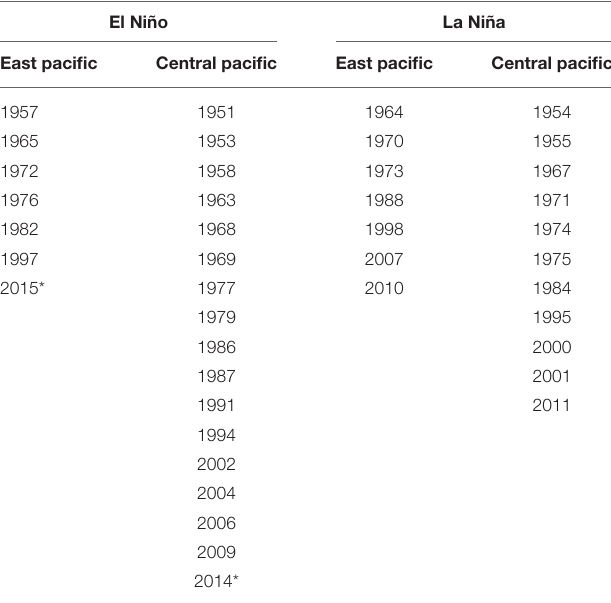
TABLE 1 | Classification of ENSO periods according to Wiedermann et al. (2016) on the basis of a comprehensive literature synthesis and a consistent classification using the network-based transitivity